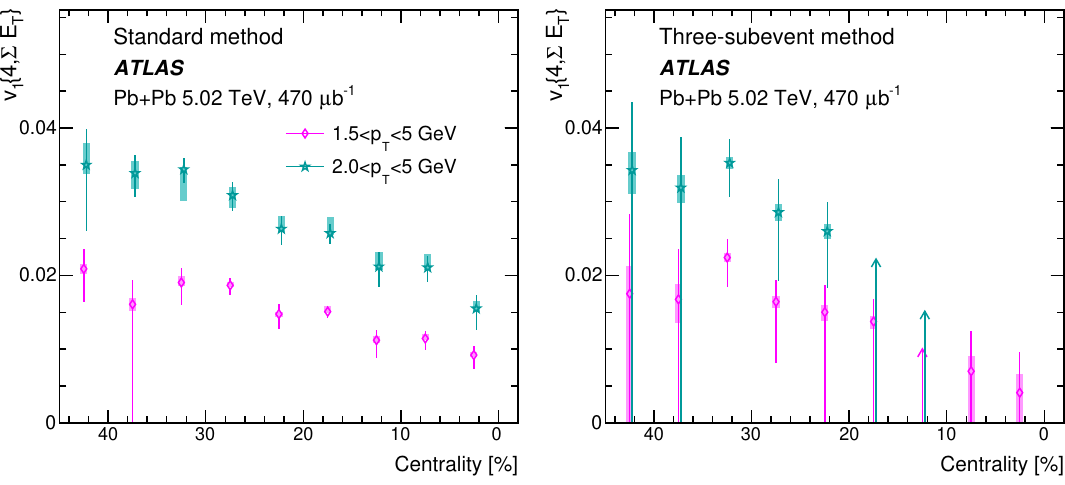
Figure 9 . The centrality dependence of v 1 f 4 g calculated for charged particles in two p T ranges with the standard method (left panel) and three-subevent method (right panel). The error bars and shaded boxes represent the statistical and systematic uncertainties, respectively.